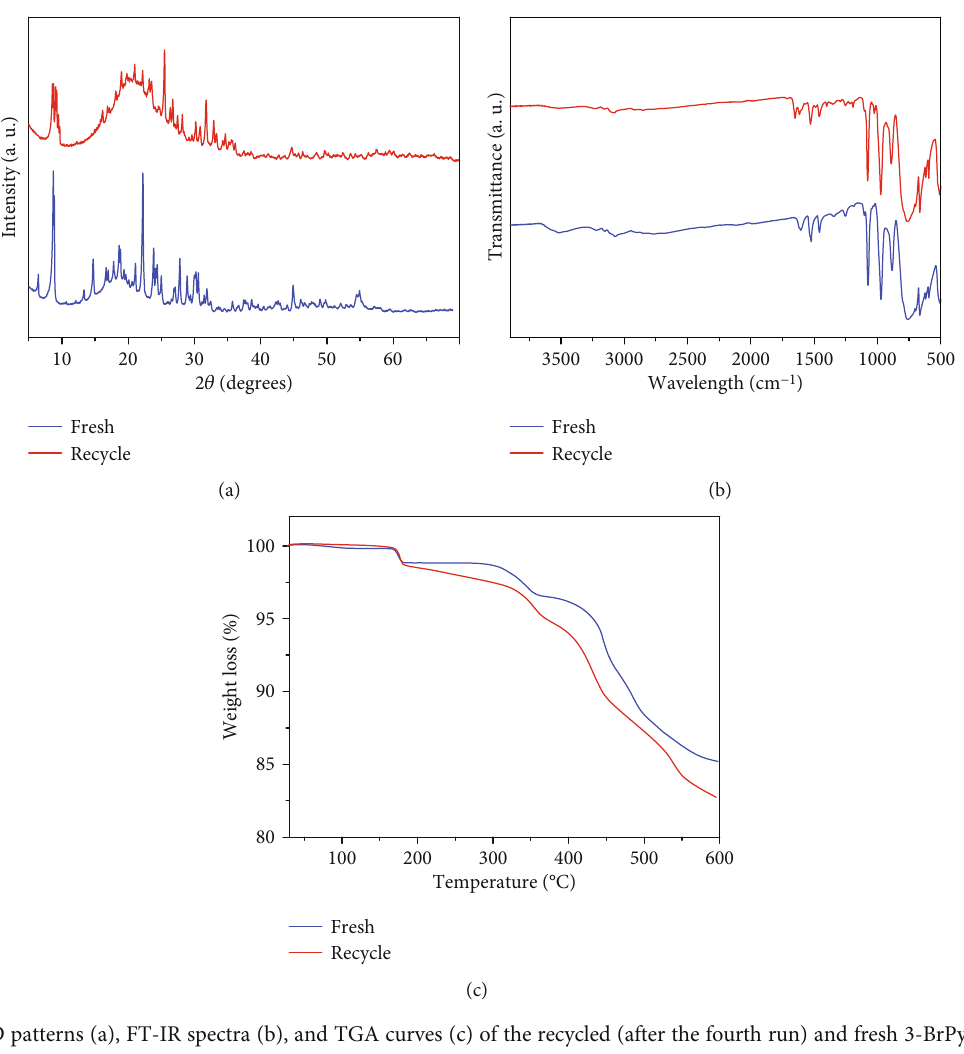
Figure 9: XRD patterns (a), FT-IR spectra (b), and TGA curves (c) of the recycled (after the fourth run) and fresh 3-BrPyPW catalysts.